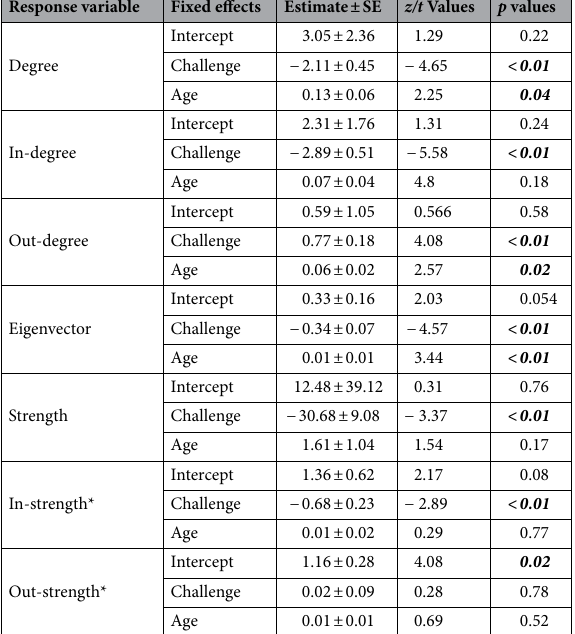
Table 2. Results of linear mixed-effect models for directed networks of bull calves (35.9 ± 8.8 days of age) housed in groups (6 calves/pen): centrality metrics, testing the main fixed effects of calves exposed to an experimental challenge model (inoculation with M. haemolytica) or a sham procedure (inoculation with sterile saline) and age, random effect (Pen): coefficient estimates, standard errors, t -test and p -values. Significant values are in [bold]. *Denotes Log 10 transformed